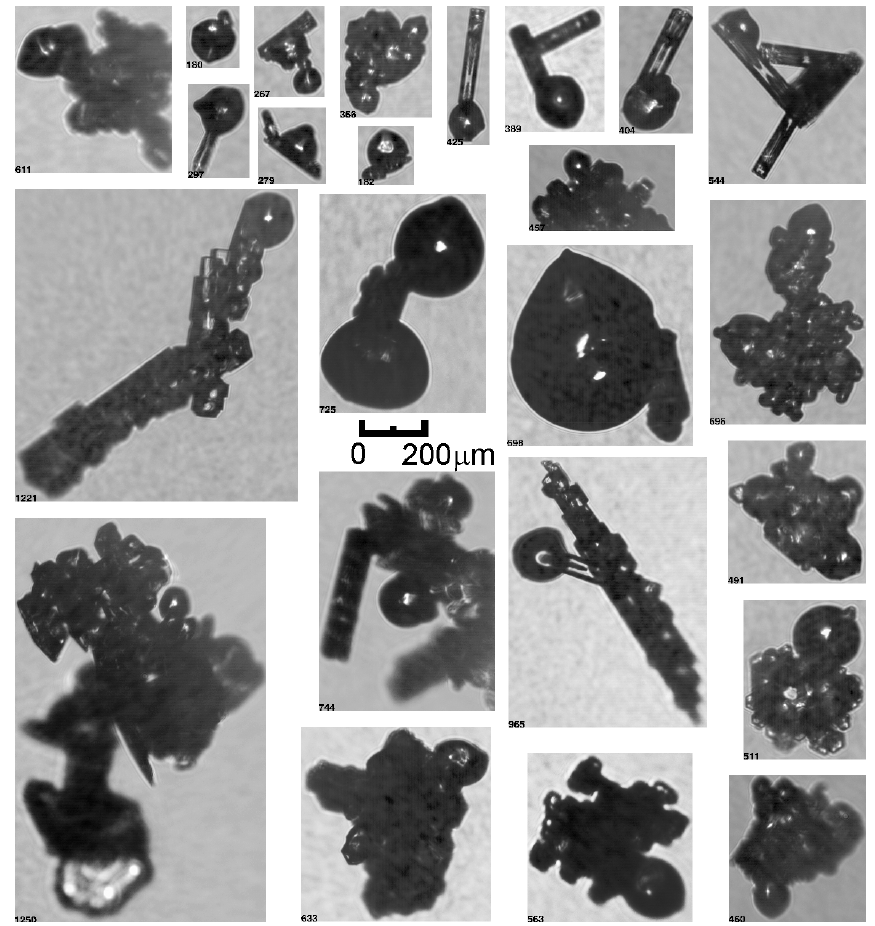
Figure 24. Images of frozen droplets attached to ice crystals that initiated their freezing. The shape of the frozen droplets was modified during freezing. Images were collected in the temperature range of − 15 ◦ C < T a < − 1 ◦